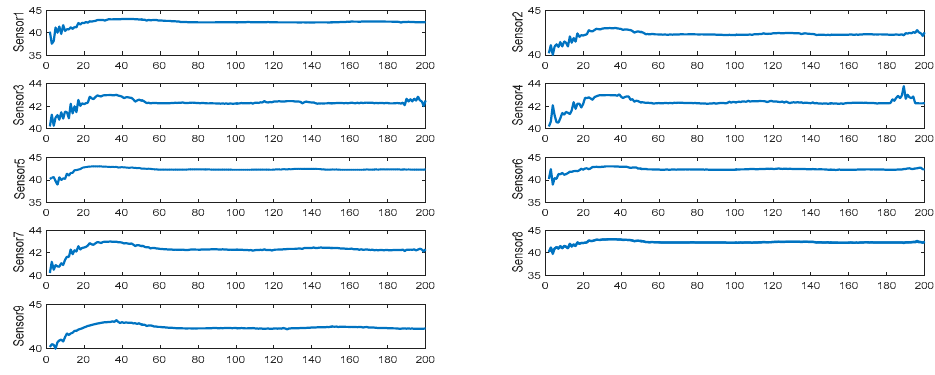
Figure 11. Simulation results of each sensor.